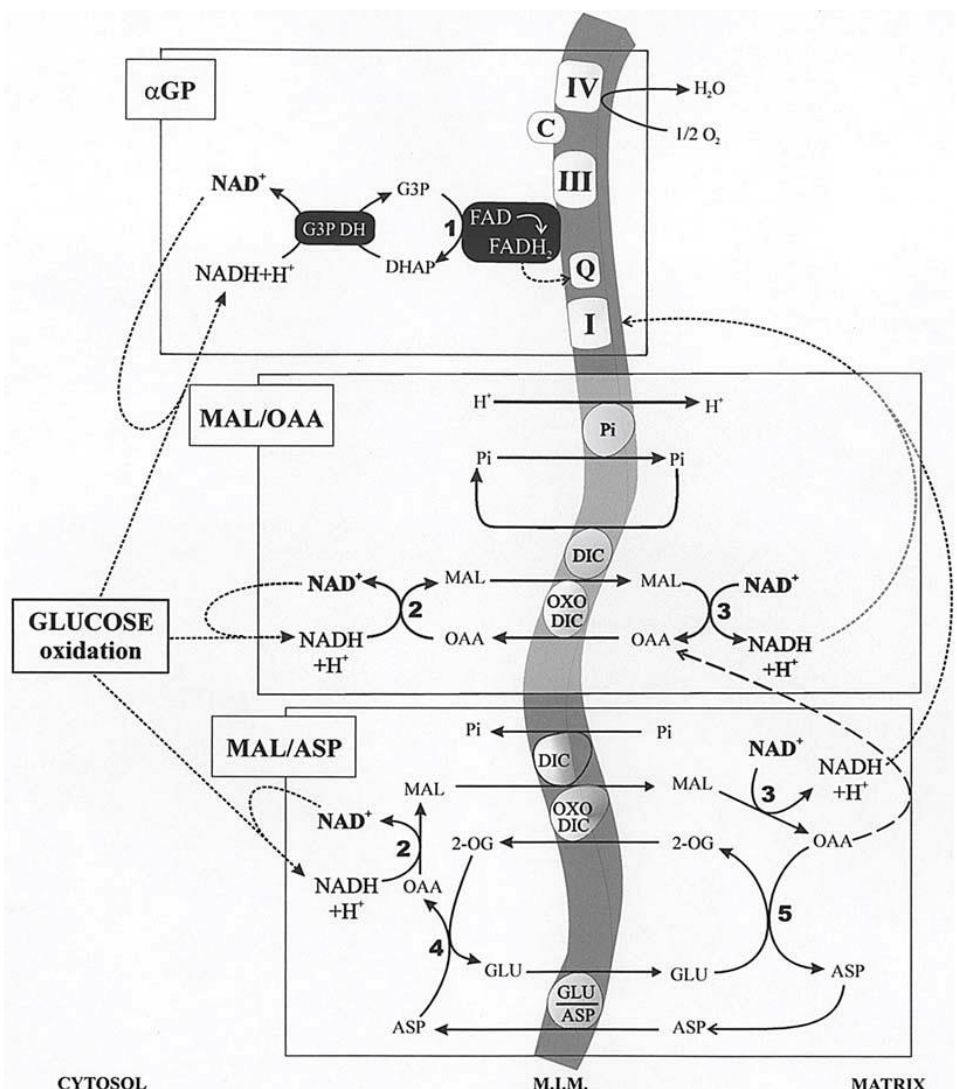
Figure 4. α GP, MAL/ASP, and MAL/OAA shuttles. MIM, mitochondrial inner membrane. Mitochondrial translocators: Pi, phosphate carrier; DIC, dicarboxylate translocator; OXODIC, oxodicarboxylate translocator; GLU/ASP, glutamate/as- partate translocator. Enzymes: 1, mitochondrial GPDH; 2 and 3, cytosolic and mitochondrial MDH respectively; 4 and 5, cytosolic and mitochondrial AAT respectively. From Atlante et al. [32] and Passarella et al. [12]. See text for details . The malate/oxaloacetate shuttle (MAL/OAA) shuttle has already been proposed in 1960 by Klingenberg and Bucher [33]. It invoked the mitochondrial export of OAA in ex- change for uptake of malate. Many researchers considered this alternative improbable, as the OAA concentration calculated from the equilibrium constant of the MDH reaction was very low and because the mitochondrial membrane was (erroneously) thought at the time to be impermeable to OAA. Indeed, a first indication of the permeability of mitochondria to OAA was offered by Haslam and Krebs [16] in 1968, later Gimpel et al. [34] suggested that OAA was transported in RLM via the dicarboxylate carrier. The in vitro transport of OAA in isolated RLM was later shown by checking the OAA capability to cause efflux of labeled dicarboxylates from loaded mitochondria [35,36]. In this case, the millimolar OAA concentration, a very high concentration compared to the micromolar physiological one, poses some doubts about the possible occurrence of OAA traffic across the mitochondrial membrane in vivo. Nonetheless, the use of the dicarboxylate carrier in OAA transport was ruled out since Pi efflux, due to externally added OAA, considered as an indication of